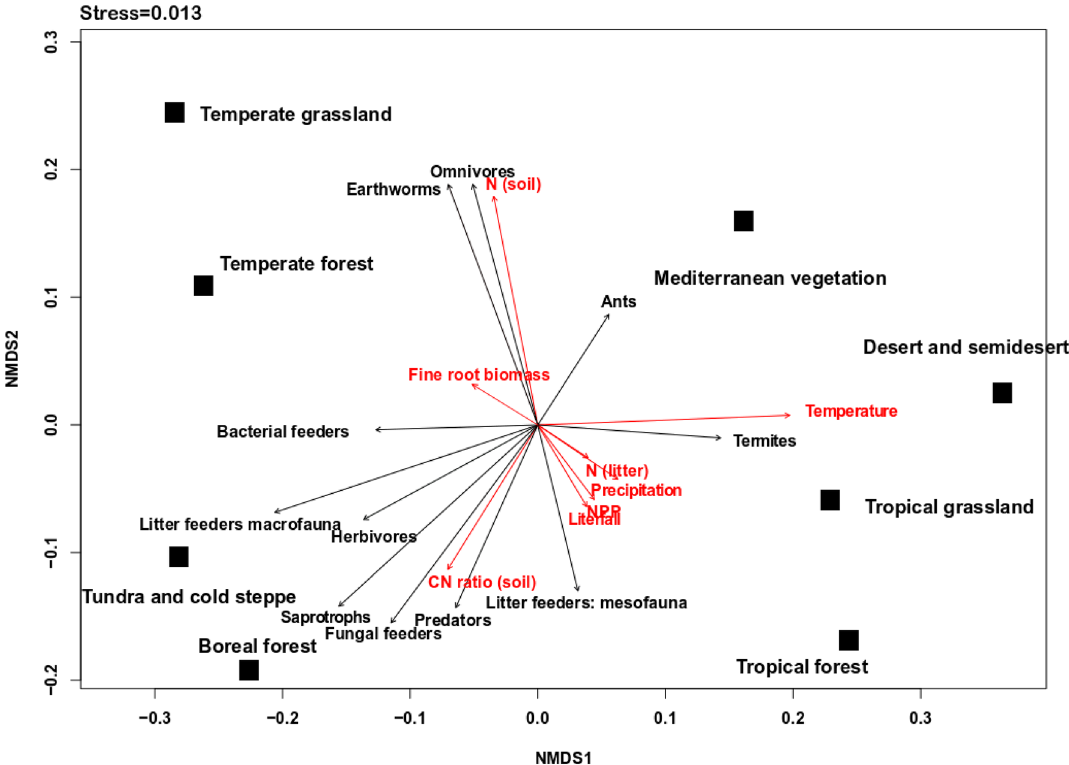
Figure 2. Non-metric multidimensional scaling (NMDS) of climatic factors, litter quality, and biomass of soil fauna functional groups. Red arrows indicate climatic factors and litter quality. Black arrows indicate biomass of soil fauna functional groups. NMDS procedure computed configuration in 999 iterations with a stress value of